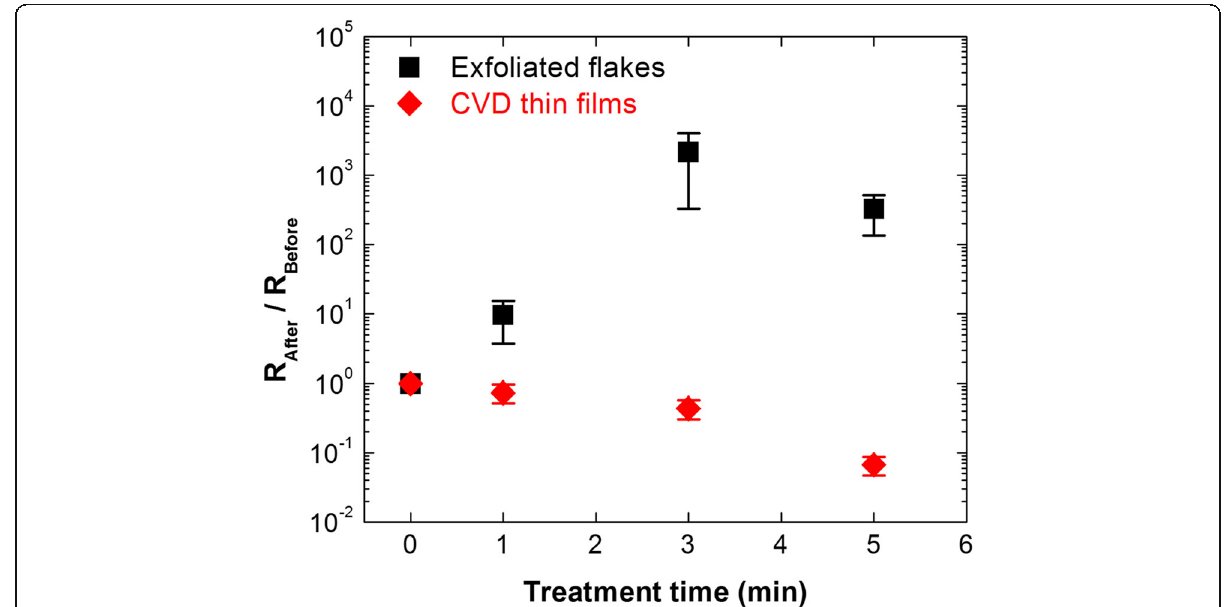
Fig. 6 Ratio of electrical resistance of MoS 2 monolayers as a function of UV-O 3 treatment time ( R After : electrical resistance after UV-O 3 treatment, R Before : electrical resistance before UV-O 3